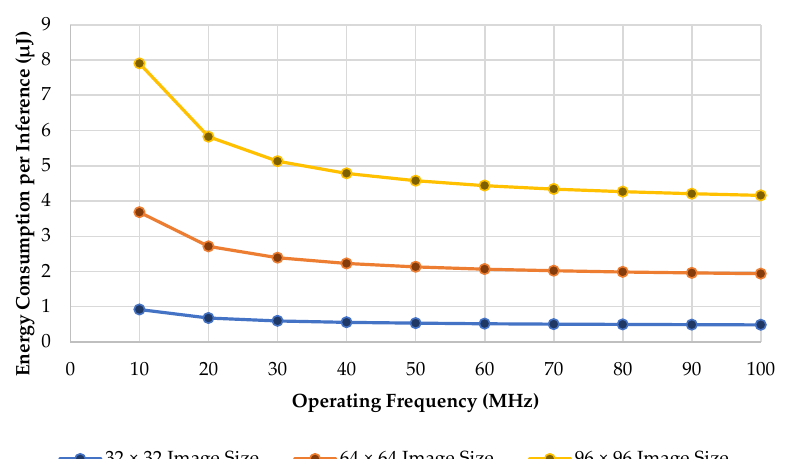
Figure 10. Utilization of each convolution layer.